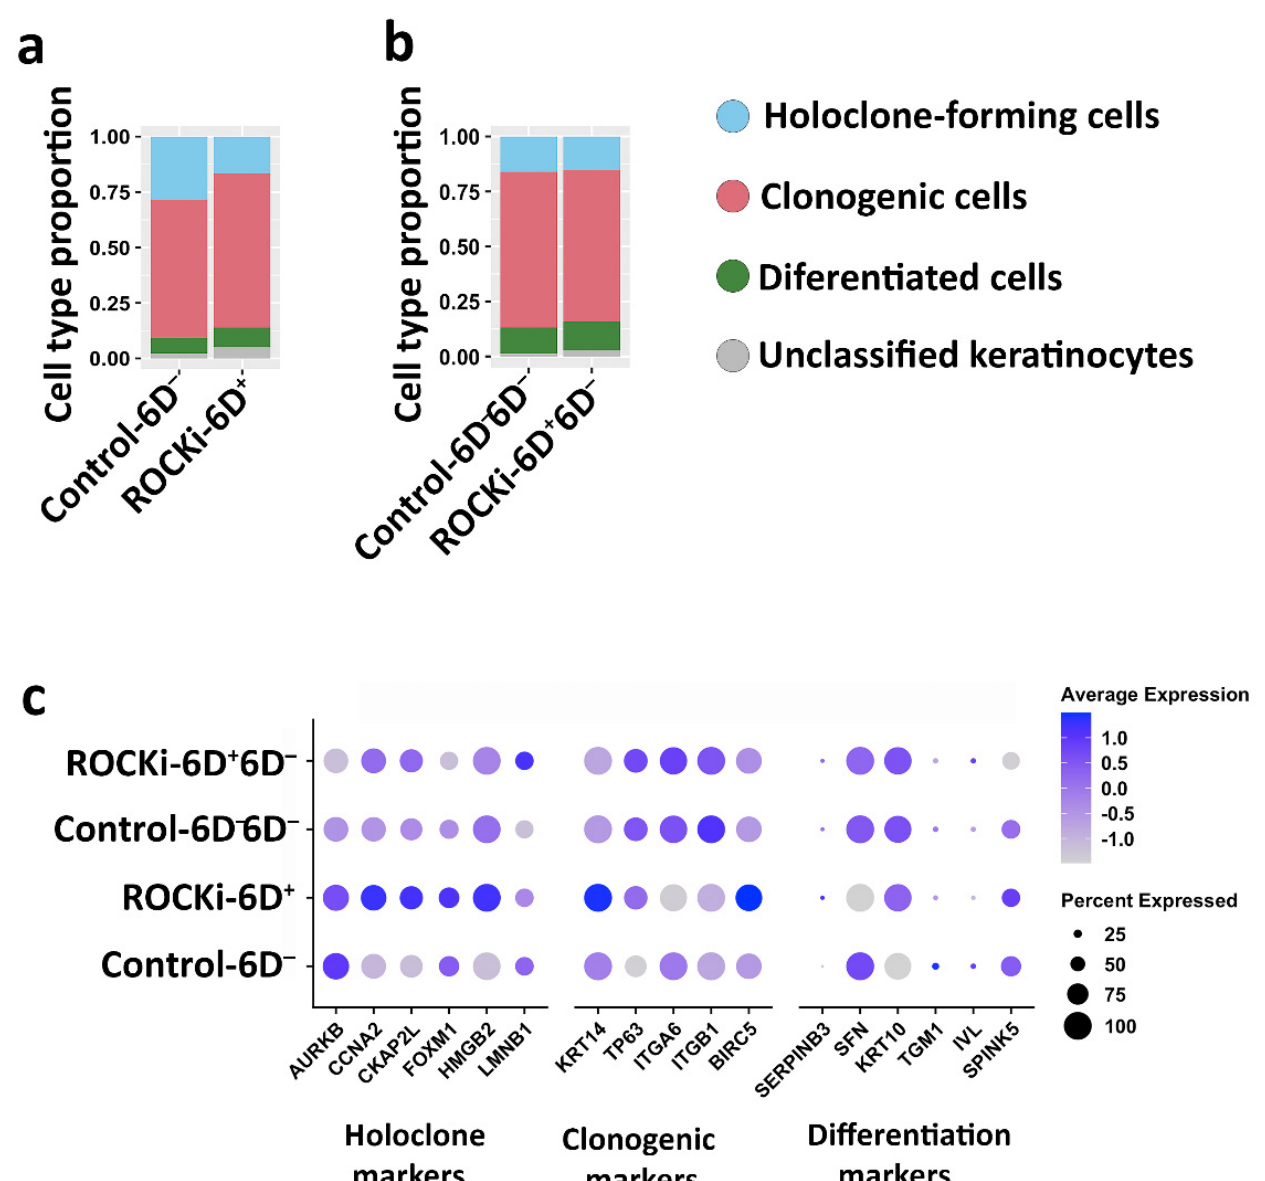
Figure 6. Cell type proportions and gene expressions with and without ROCKi treatment. Cell type populations were analysed using the transcriptomes for holoclone, clonogenic, and differentiated cell markers. Differences in cell type proportions were detected between non-treated cells (Control-6D − ) and ROCKi-treated cells (ROCKi-6D + ) ( a ), whereas there was no difference between non-treated cells (Control-6D − 6D − ) and ROCKi-withdrawn cells (ROCKi-6D + 6D − ) ( b ). Dot plots show the expression of markers for holoclone-forming, clonogenic, and terminally differentiated cells in different cultures ( c ).